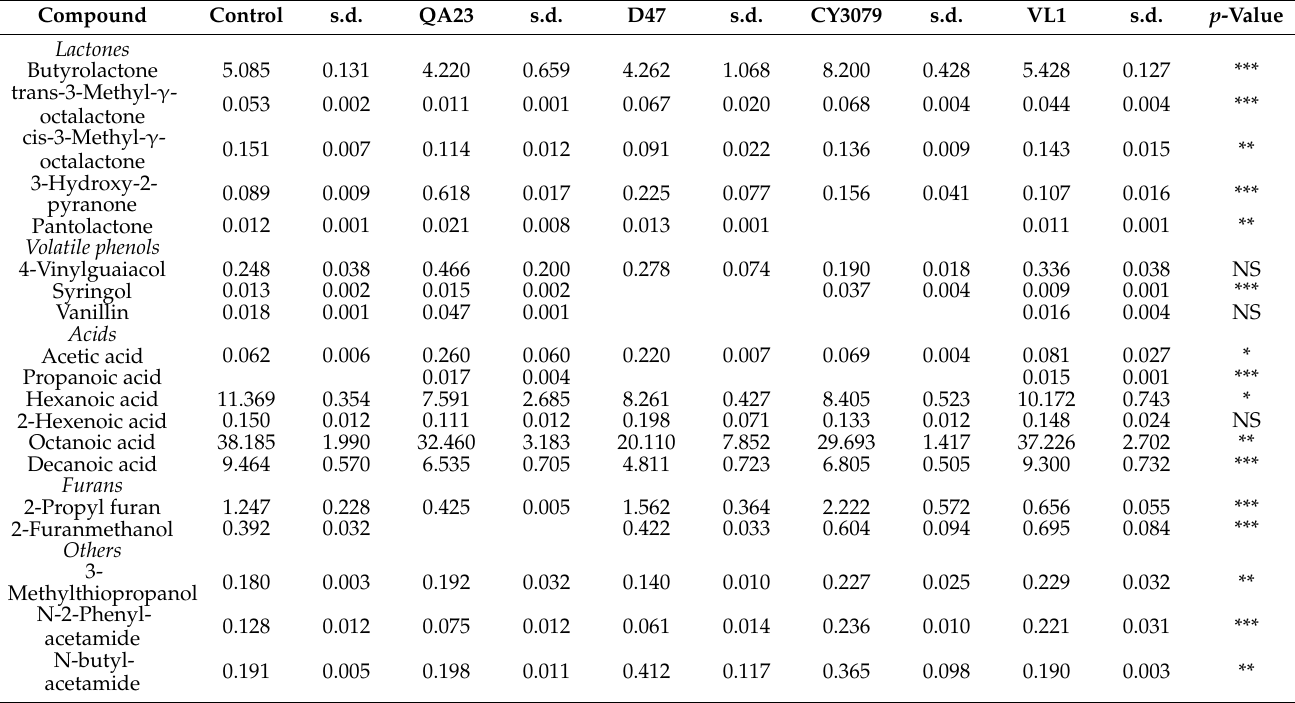
Numbers indicate the concentration of volatile compounds, as the average from three replicates, and the standard deviation. NI = control; QA23 = S. bayanus Lalvin; D47 = S. cerevisae Lalvin; CY3079 = S. cerevisae Lalvin; VL1 = S. cerevisae Zymaflore. NS = not significant ( p > 0.05). Asterisks indicate significant differences between treatment-related samples (* p < 0.05; ** p < 0.01; *** p <